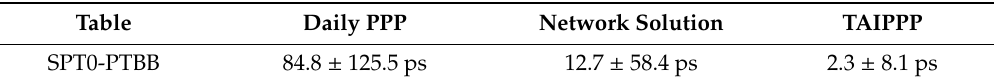
Table 2. Average absolute value and standard deviation of the day boundary discontinuities for PPP and network solution.